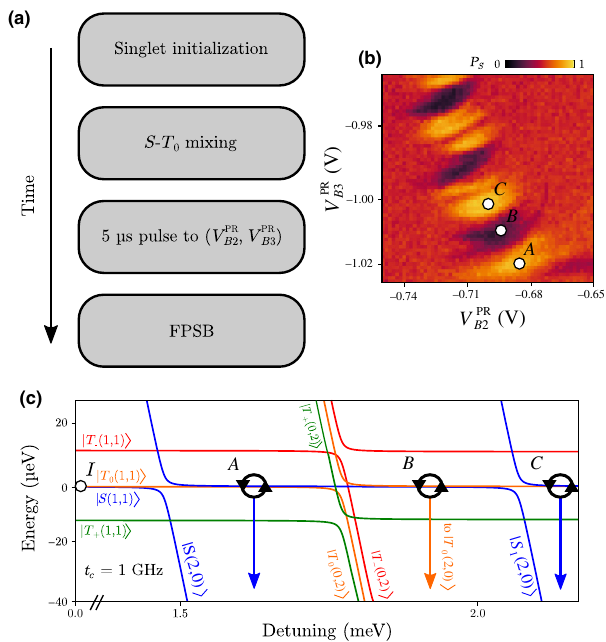
FIG. 7. Calibration of the relaxation hotspot in the voltage- gate space. (a) Experimental workflow used to identify the relaxation hotspot where parity readout is performed. The sys- tem is initialized in a singlet state and pulsed in the (1,1) charge region at a low value of tunnel coupling in order to prepare an equipartition of S and T 0 population. The system is then pulsed , V PR ), finally a FPSB procedure during 5 µ s at coordinates ( V PR B 2 B 3 is applied to determine the proportion of S at the end of the relaxation pulse. (b) Singlet probability at the end of the pulse sequence presented in (a) as a function of the pulse coordinates , V PR ). We observe lobes of high singlet probability indicat- ( V PR B 2 B 3 ing that the initialized T 0 state has relaxed to the S state during the 5 µ s pulse. The position C where the highest singlet proba- bility is recorded, is selected as the parity-readout position. (c) Energy diagram of the relevant spin states and identification of the region where | T 0 ( 1, 1 ) (cid:4) and | S ( 1, 1 ) (cid:4) mixing can occur. Once the | T 0 ( 1, 1 ) (cid:4) state is transformed it relaxes rapidly through phonon emission to | S 1 ( 0, 2 ) (cid:4)